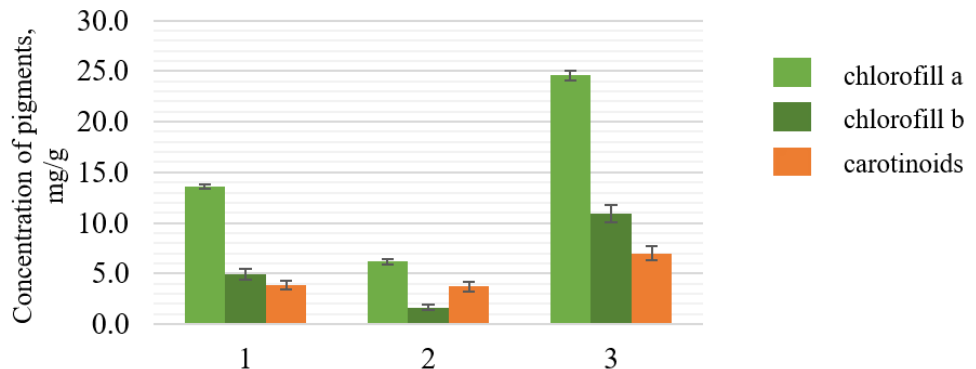
Figure 5. Influence of additives on the content of pigments in the samples of C. vulgaris BIN biomass: 1, control (no additives); 2, H 2 O 2 additive; 3, H 2 O 2 additives + pyridoxine. In order to compare homogeneous groups in the determination of pH, one-factor dispersing analysis and F-criteria analysis were used. A significant difference was found between the compared groups (F significantly greater than 1), which was assessed at p < 0.05.